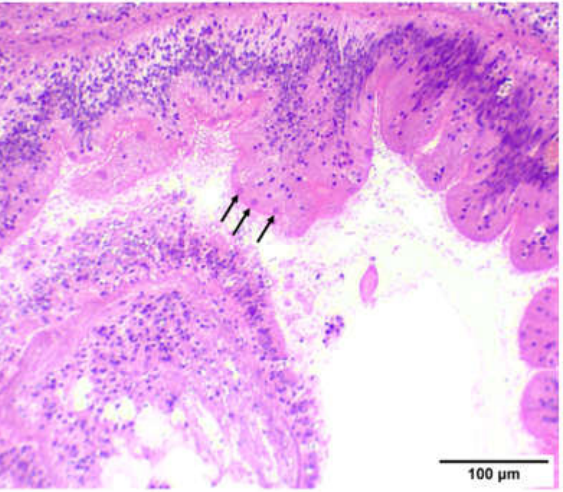
Figure 5. Young stages of M. refringens (arrows) within the epithelium of M. galloprovincialis digestive tract. H&E staining (×20 Objective).